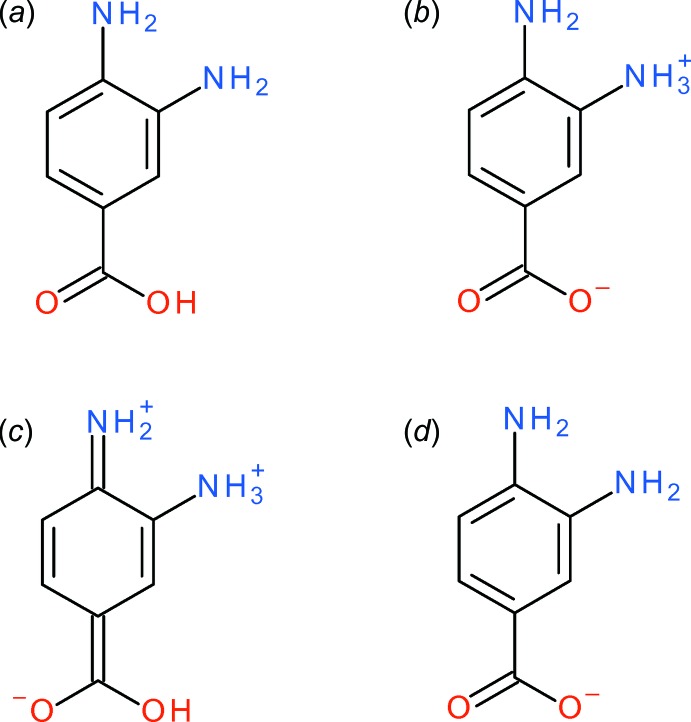
Different structures based on 3,4-di­amino­benzoic acid: (a) neutral C7H8N2O2 mol­ecule as found in DONDUH; (b) zwitterion in VODWIU; (c) quinoid resonance form of the C7H9N2O2
+ cation in the title compounds (see text and compare scheme 1); (d) C7H7N2O2
− anion as found in the metal complexes noted in the text.